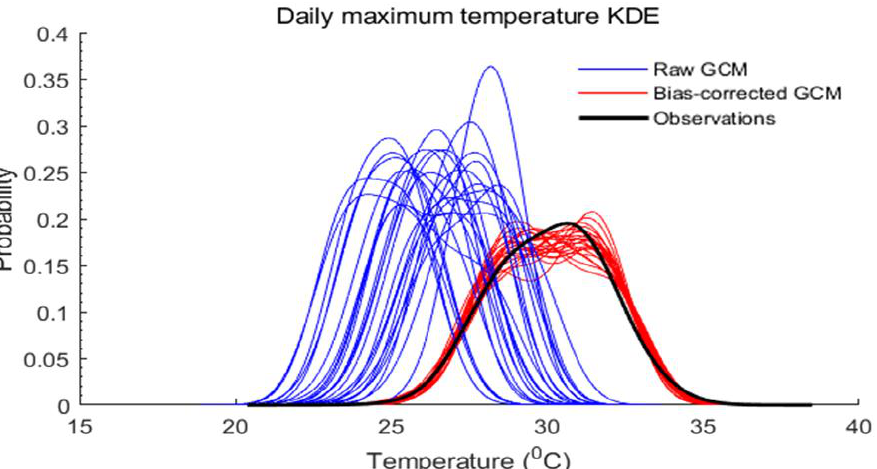
Figure 3. Daily maximum temperature KDE with raw GCM (25-model ensemble), with bias-corrected GCM and observation record for SJIA.